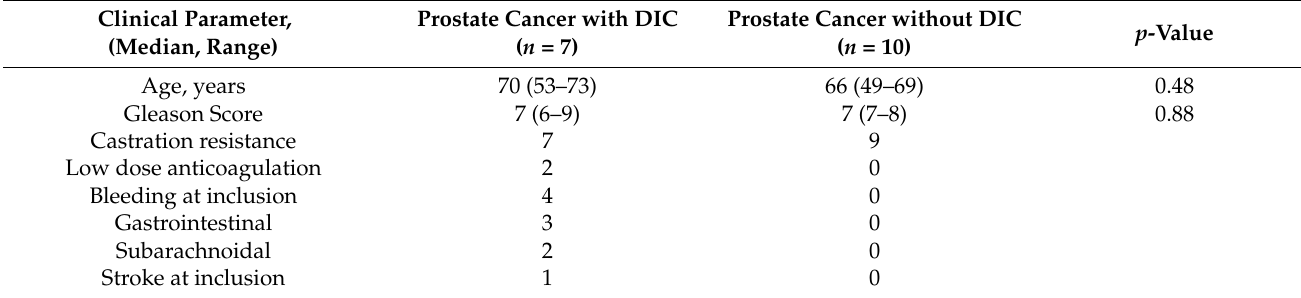
Table 1. Clinical parameters of prostate cancer patients with disseminated intravascular coagulation (DIC) and prostate cancer patients without DIC.